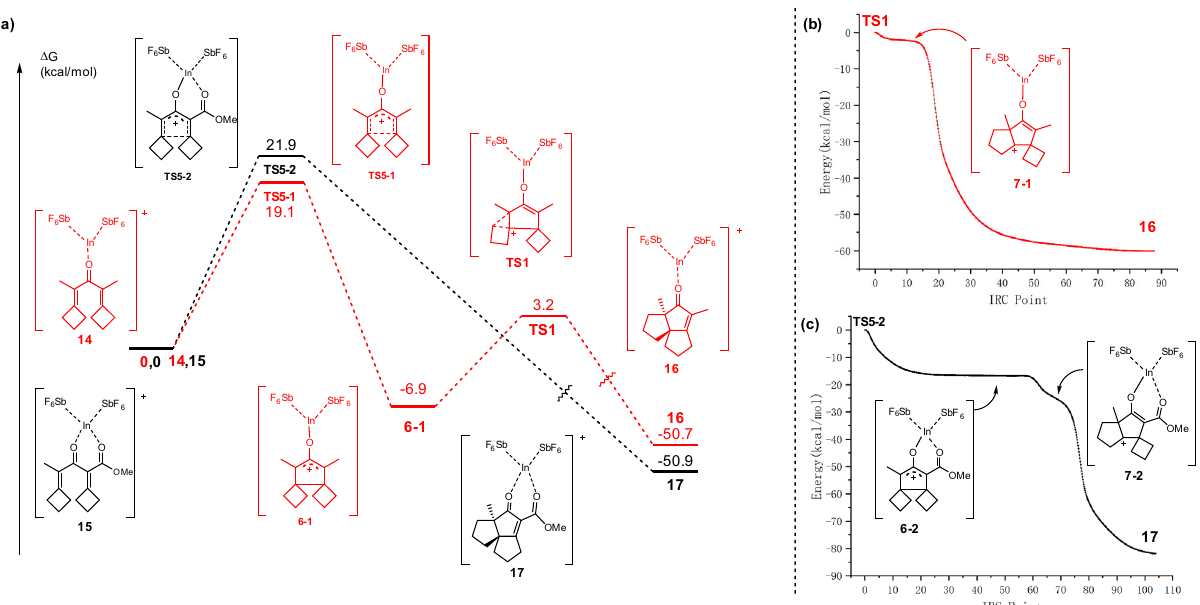
Fig. 5 Details of DFT calculations of 2a, 2w for mechanism investigation. a Computed Gibbs free energy changes of the reaction pathways in CHCl 3 . b DFT IRC pathway of the formation of 16 for the twice cyclo-expansion process from TS1 . c DFT IRC pathway of the formation of 17 for the completed Nazarov cyclization and twice cyclo-expansion process from TS5-2